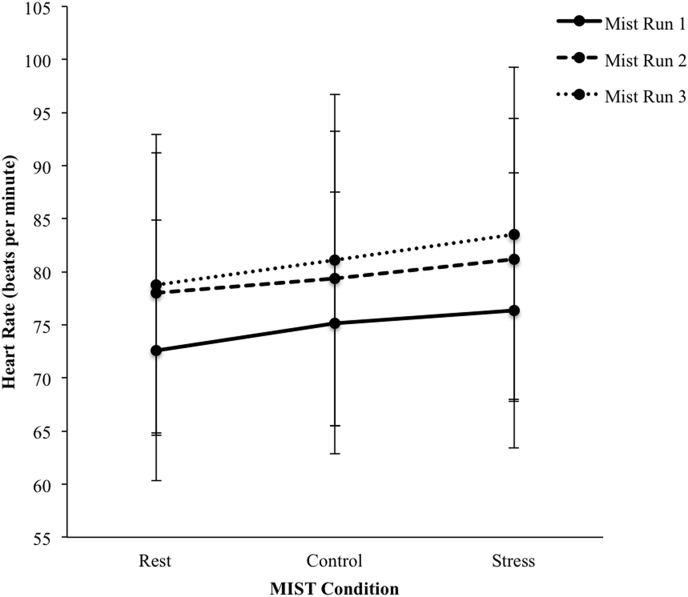
Mean HR levels for all three MIST runs during rest, control, and stress condition. Error bars represent standard deviations. MIST = Montreal Imaging Stress Task.